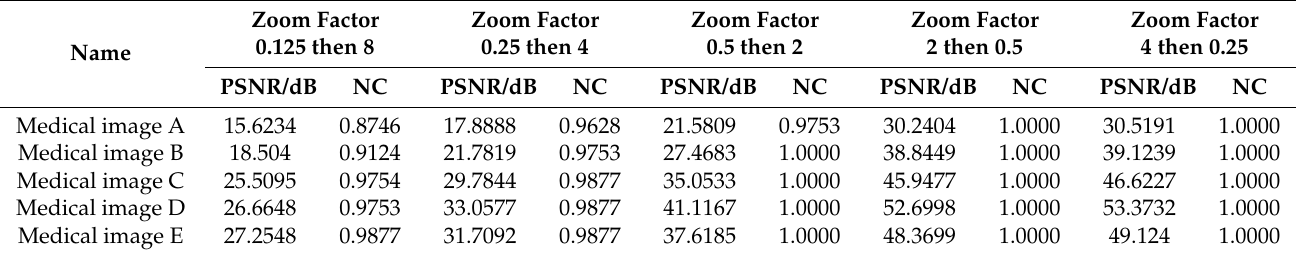
Table 5. The result under scaling attacks. Figure 13. Attacked medical images and restored watermarking images under scaling factors 0.125 then factors 8: ( a , a1 ) brain and extracted watermarking image; ( b , b1 ) chest and extracted water- marking image; ( c , c1 ) fundus blood vessels and extracted watermarking image; ( d , d1 ) hand and extracted watermarking image; and ( e , e1 ) breast and extracted watermarking image.